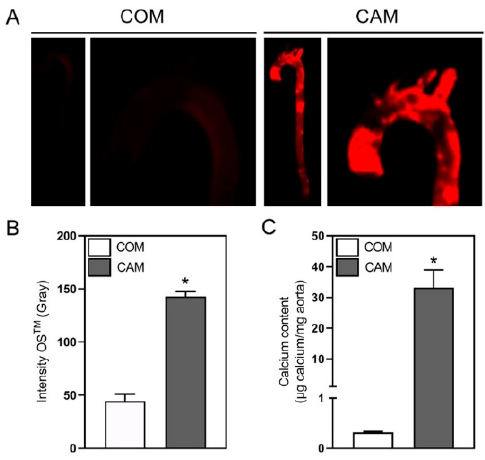
Figure 1. Hydroxyapatite and calcium quantification in aortic tissue. ( A ) Representative images of ex vivo thoracic aortic staining with OsteoSense™680EX (OS TM ) upon stimulation with control medium (COM) or calcification medium (CAM), respectively, for 7 days. ( B ) Quantification of fluorescence signal. ( C ) Quantification of aortic calcium amount via photometric assay upon decalcification in hydrochloric acid. N = 3, mean ± SEM, * p < 0.05.